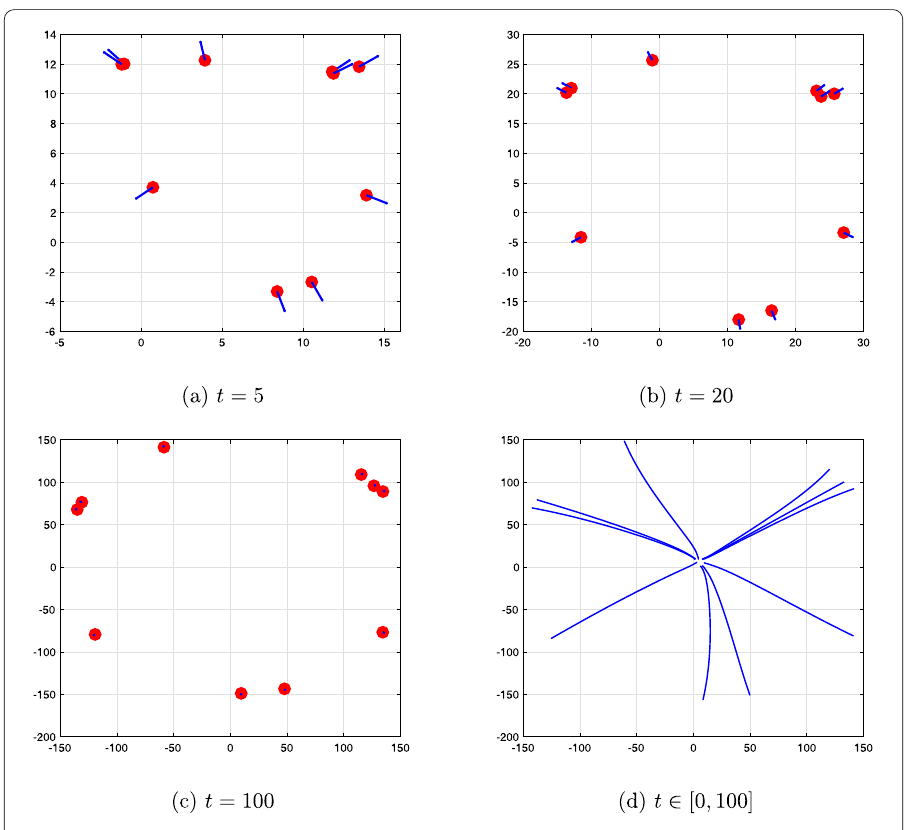
Figure 10 Simulation of the second-order swarming model with time delay ( τ = 5) for five agents, N = 10, and time t ∈ [0,100]. The corresponding parameters are given as α = 0.7, β = 0.5, C a = 1, l a = 1, C r = 5, and l r = 100. The position of each agent is depicted by a circle and the velocity is represented by a vector at agent’s position